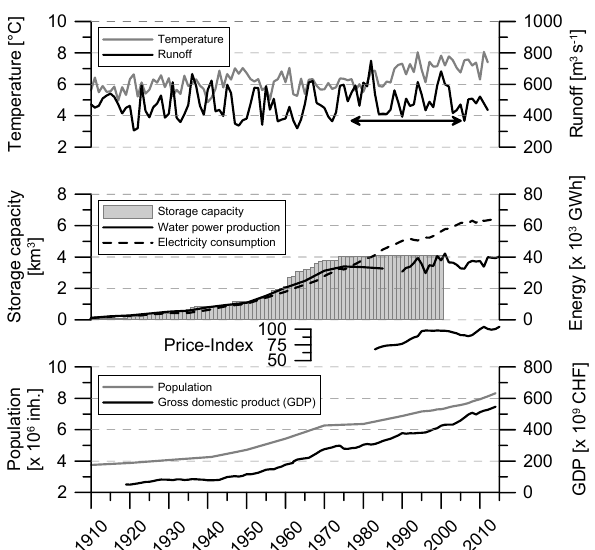
Figure 2. Annual data of water storage capacity of dams, water power generated (storage plus runoff power plants), and electric- ity consumed, hydrometeorologial conditions and socio-economic drivers in Switzerland since 1910. Runoff (lowest daily flow) and temperature refer to hydrological years (November–October). The arrow marks a period of a higher level of low flows after 1970. (Data sources: cf. Table